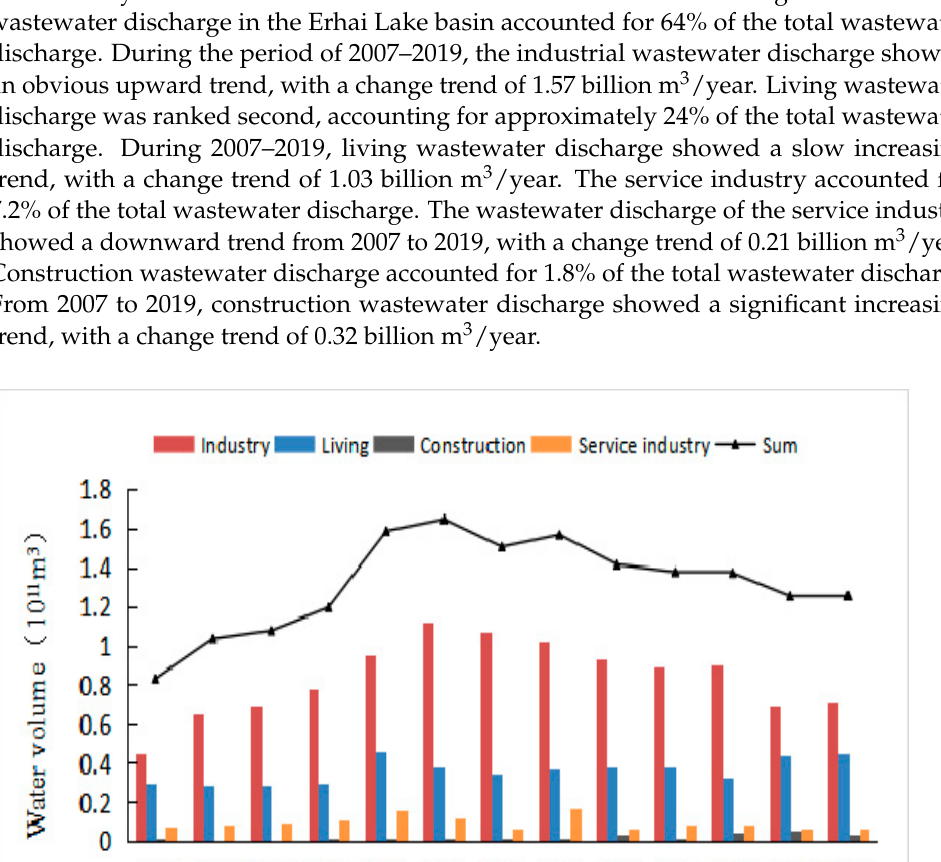
Table. 5 Correlation coefficient between different water consumption and water volume